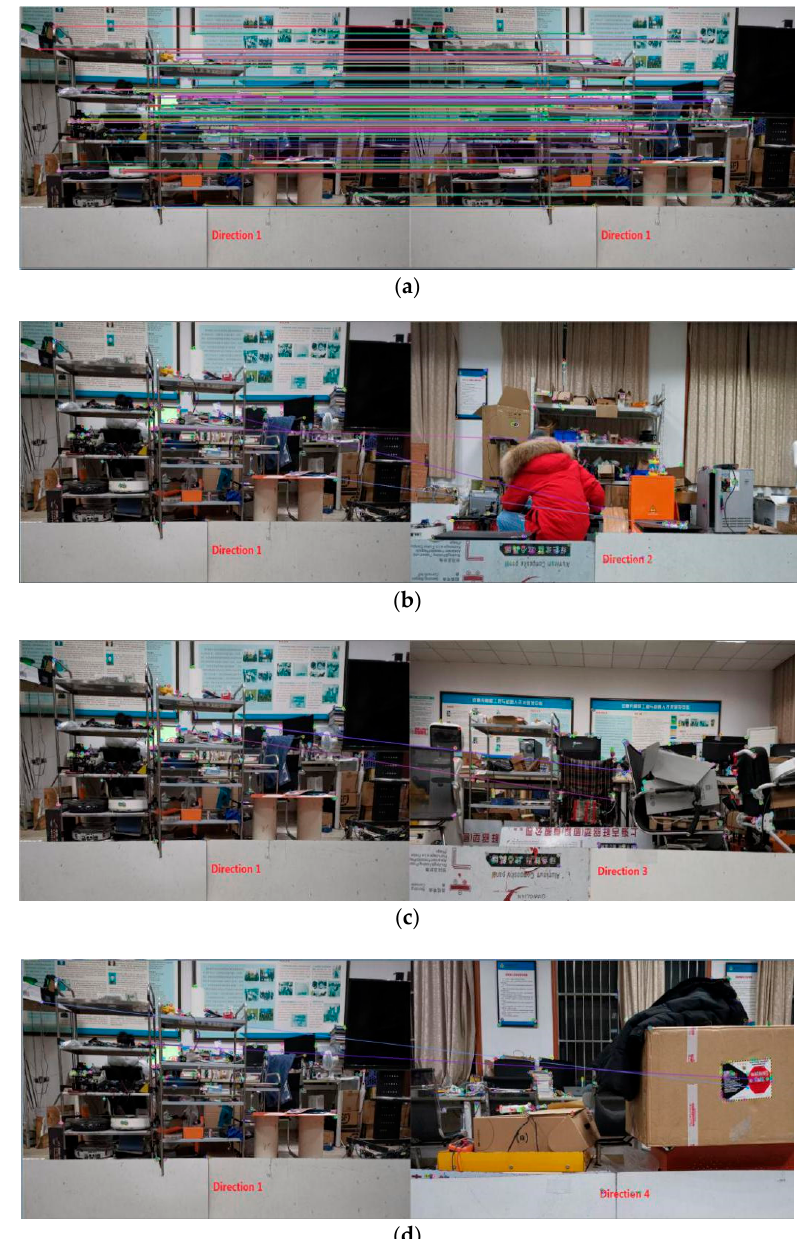
Figure 13. ORB features and matching lines. ( a ) Image captured from direction 1, doubled; ( b ) Image captured from direction 1 with that from direction 2; ( c ) Image captured from direction 1 with that from direction 3; ( d ) Image captured from direction 1 with that from direction 4.